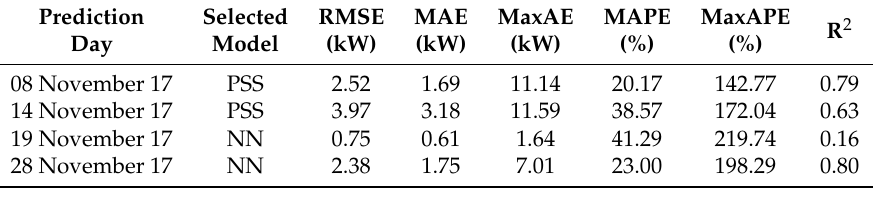
Table 4. Pilot systems: School (Palo del Colle). Computational Results. (UpdFreq = 24 h).